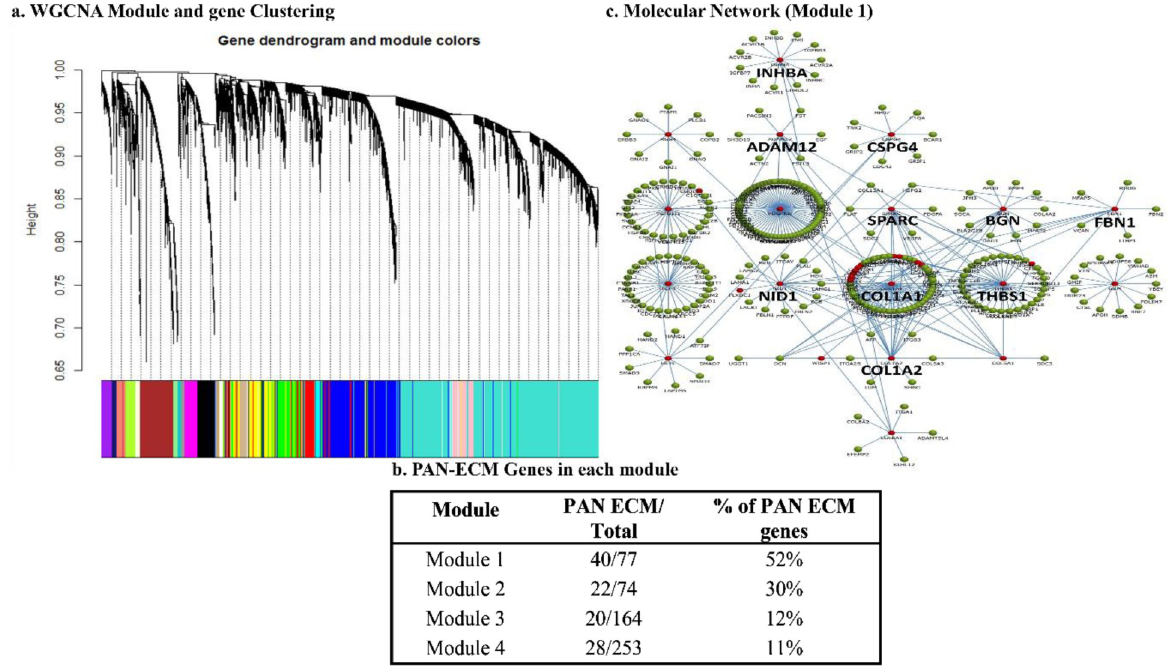
Fig 7. Gene coexpression network during endometrial cancer (EC) development. (a) A WGCNA study for gene coexpression network analysis between late and early stages of EC disease was carried out to determine the relationships between PAN-ECM genes and the other co-expressed differential exressed genes (DEGs) during EC development was varried out. (b) Percentage of PAN-ECM genes in each generated WGCNA module was indicated. (c) The identified hub genes and their molecular interaction of the molecular network of the genes in module 1 by FunRich analysis.